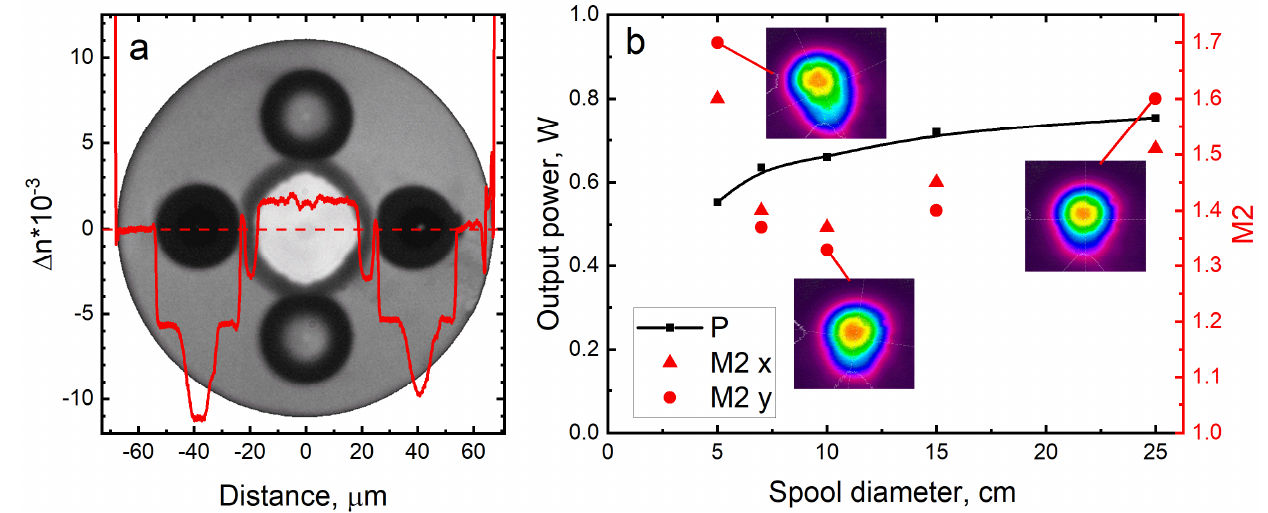
Figure 9. ( a ) Measured refractive index profile of the Er-doped fiber and image of the fiber end facet; ( b ) measured output power and corresponding M 2 -factor under different fiber bending conditions.